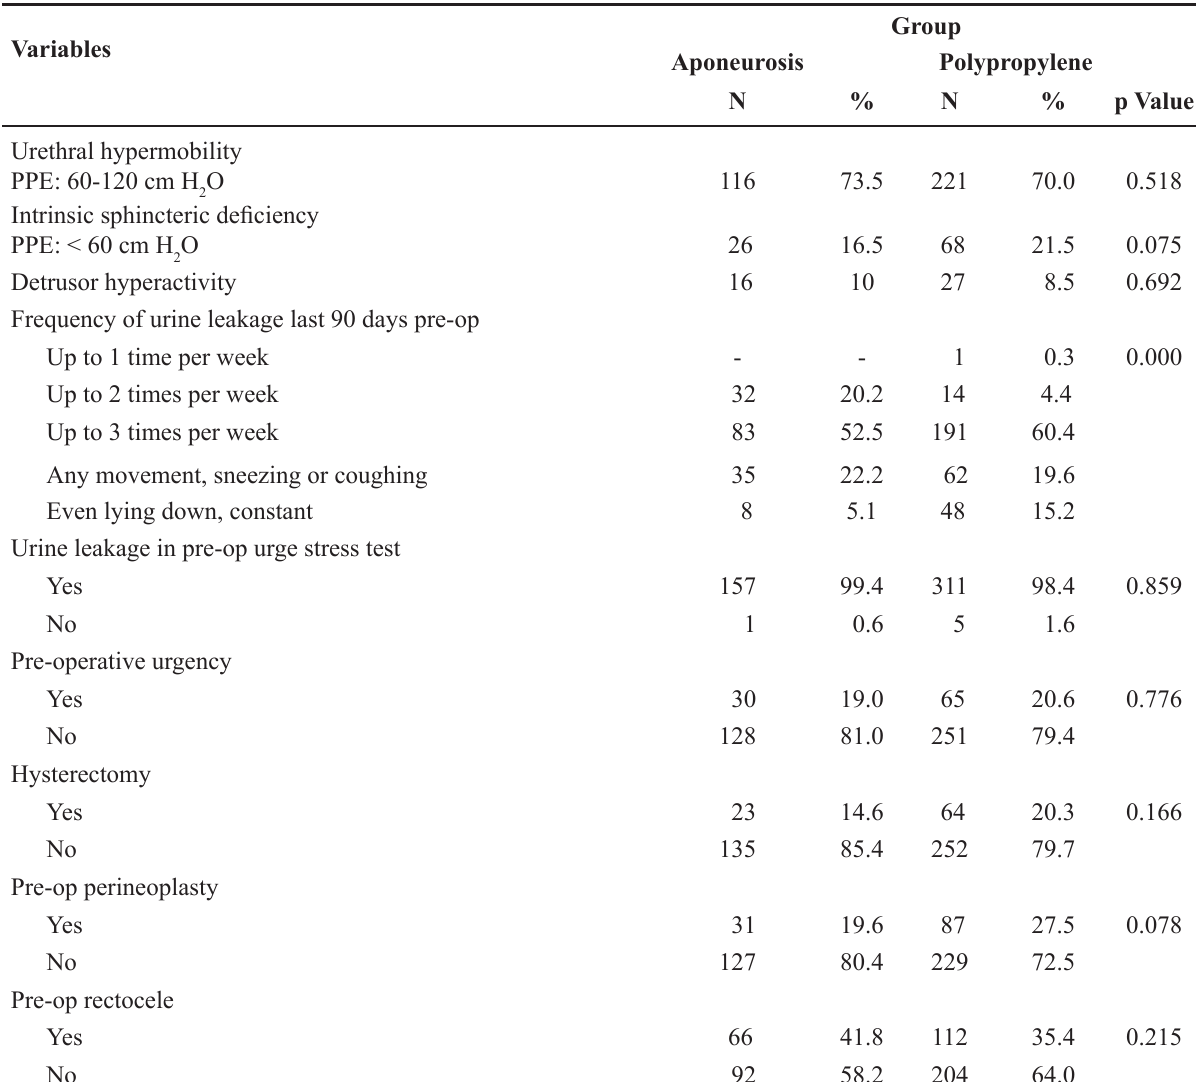
Table 1 – Characterization of the women who underwent surgery for urinary incontinence, according to a pre-operative urodynamic study and clinical